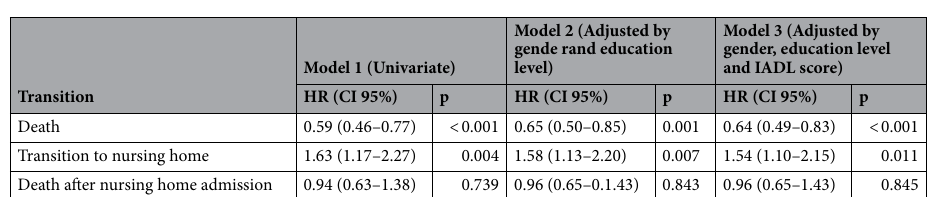
Table 1. Baseline characteristics of participants of 3C study and characteristics of the residents at the time of entry into senior housing.